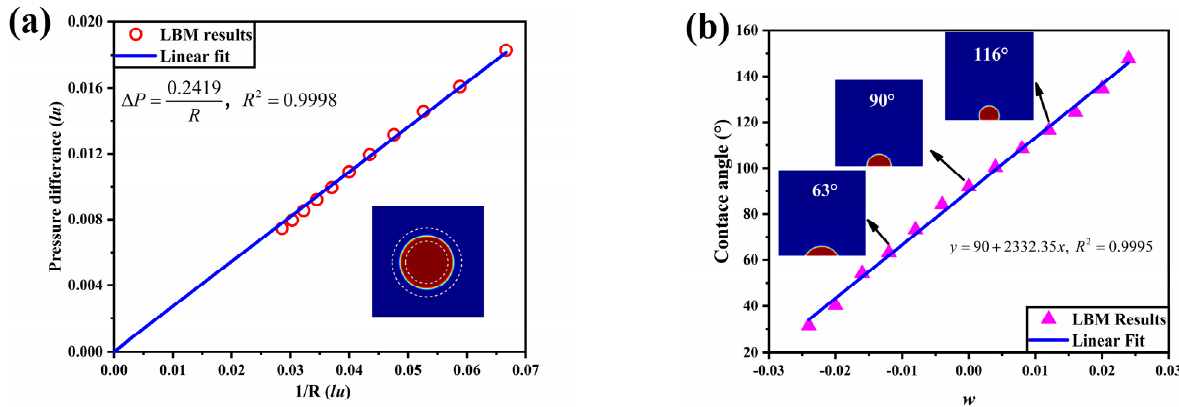
Figure 1. ( a ) The pressure difference as a function of the 1/R; ( b ) The contact angles of the droplet on the solid plane as a function of w.